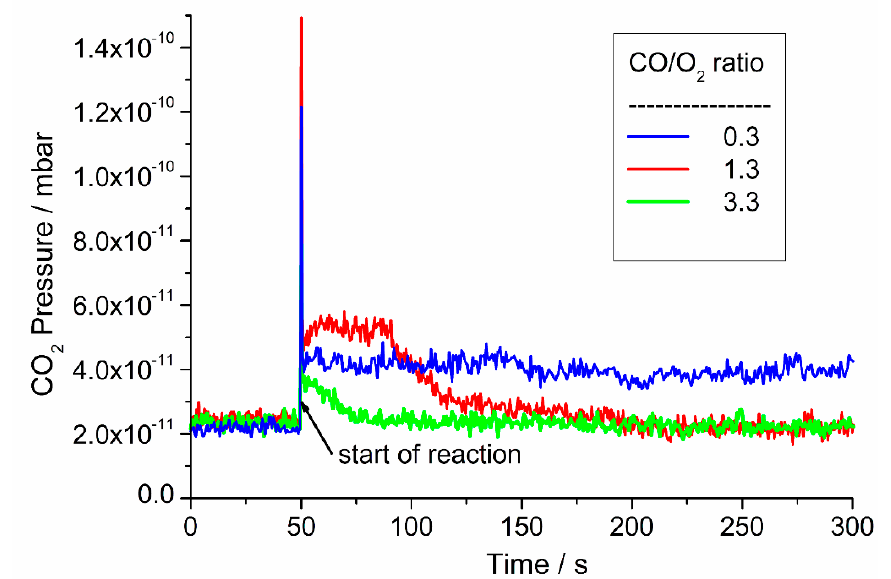
Figure 10. CO 2 evolution during the introduction of a mixture of CO and oxygen on a clean Pt{110} surface with a molecular beam at a constant temperature of 370 K. CO/O 2 ratios are 0.3 (blue curve), 1.3 (red curve) and 3.3 (green curve).